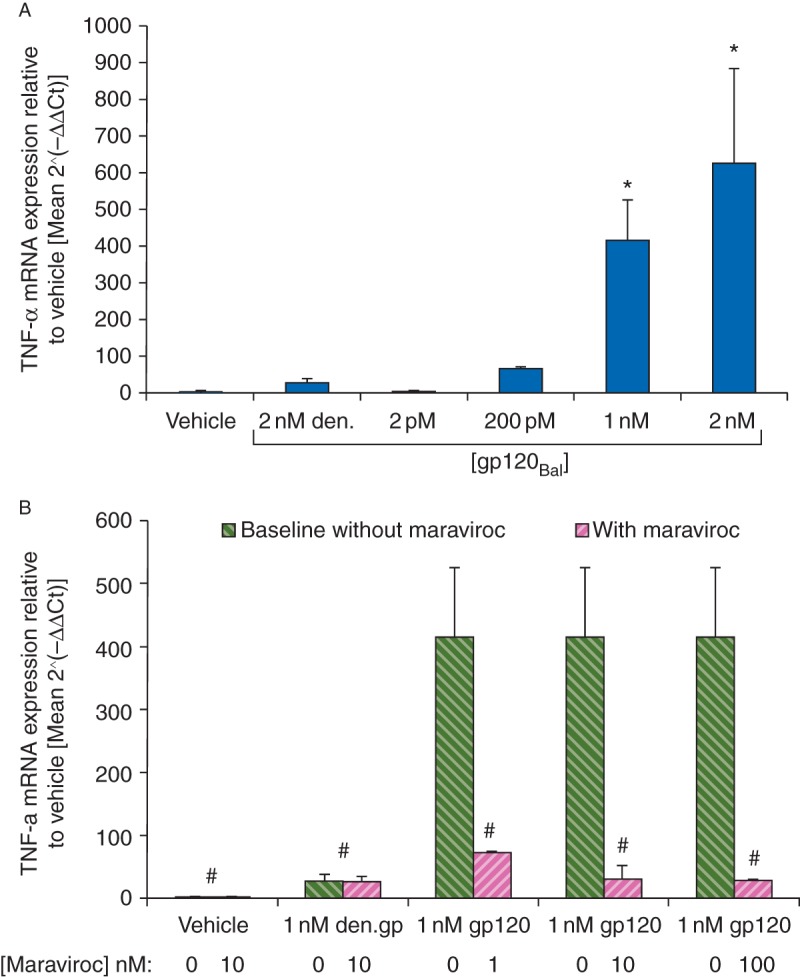
TNF-α expression changes in BMDMs after gp120 exposure and inhibition with the CCR5 antagonist maraviroc. (a) gp120Bal induced a concentration-dependent increase in TNF-α expression after 4 h stimulation of BMDMs with vehicle, 2 nM denatured-gp120Bal or 2, 200 pM, 1 or 2 nM gp120Bal, in IMDM. Data presented as mean 2−ΔΔCt-fold change (sd), n=4. *P<0.05 vs vehicle- and den.gp120-treated control levels using one-way anova and Tukey's post hoc analysis. (b) Primary BMDM cells were pretreated for 1 h with either vehicle control or 10 nM maraviroc and then exposed for 4 h to either vehicle, 1 nM denatured-gp120Bal ,or 1 nM gp120Bal diluted in IMDM or presence of 1, 10, or 100 nM maraviroc. Changes in TNF-α mRNA gene expression were assessed relative to vehicle control. Data presented as mean 2−ΔΔCt-fold change (sd), n=4. *P<0.05 vs 1 nM gp120-treated baseline values using two-way anova and Tukey's post hoc analysis.